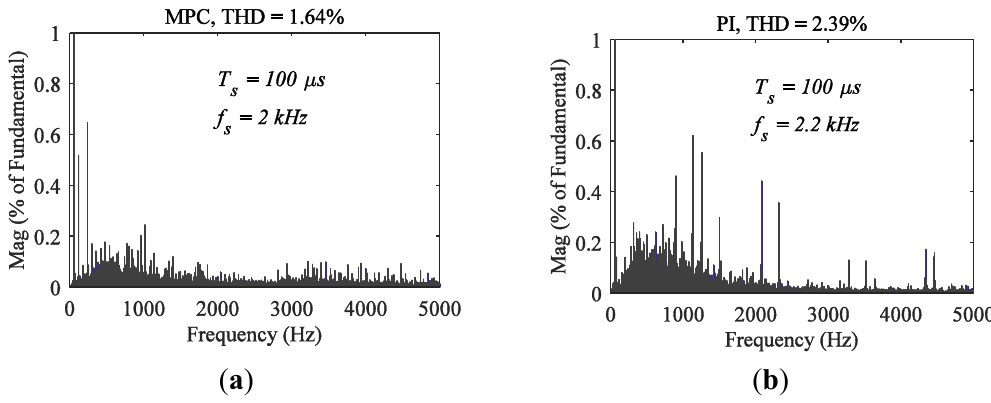
Figure 10. Load voltage spectrum and THD: ( a ) MPC technique; ( b ) PI